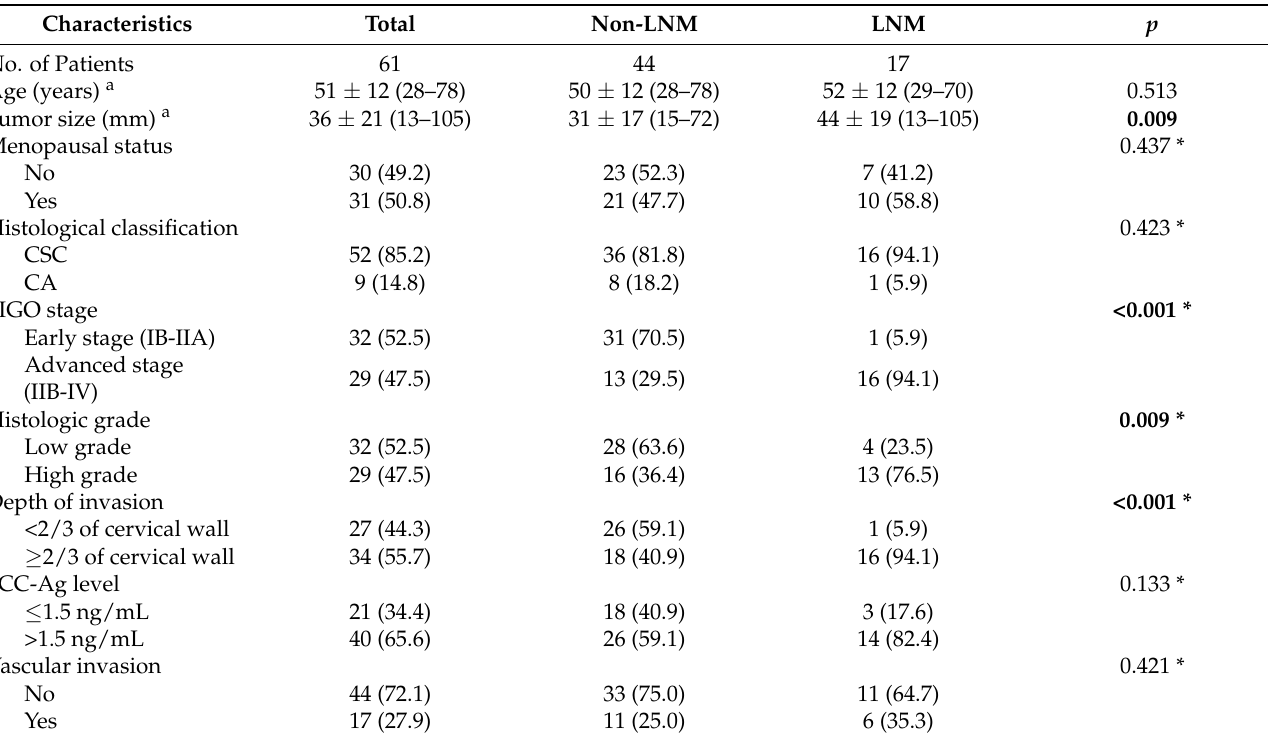
Table 1. Clinicopathological characteristics and lymph node status of patients with cervical